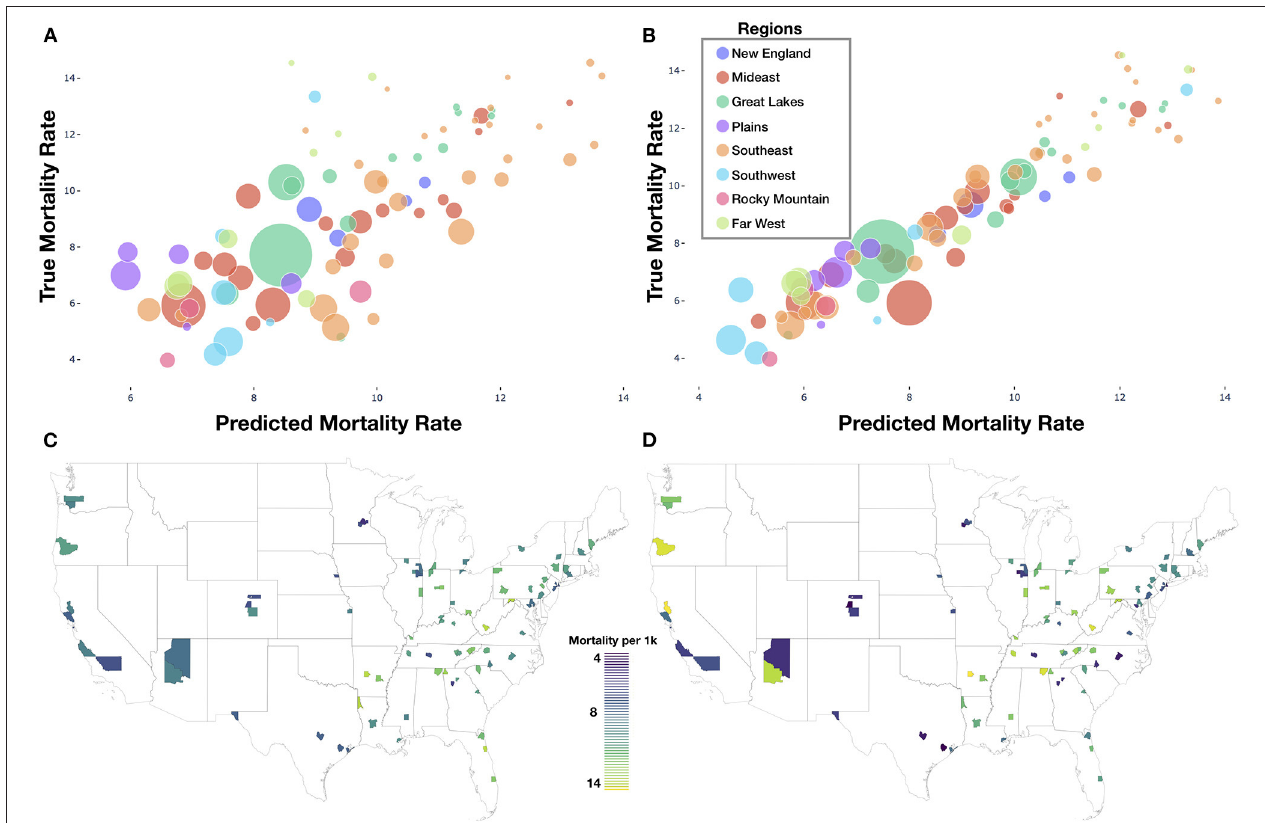
FIGURE 3 | Model results: (A) deep learning predicted vs. true mortality for each test county; (B) linear model predicted vs. true mortality for each test county; (A,B) legend contains look-up dictionary for naming of US regions featured in the rest of the study; size of bubble is correspondent to population size of county; (C) predicted mortality plotted geographically for test counties; (D) true mortality plotted geographically for test counties.